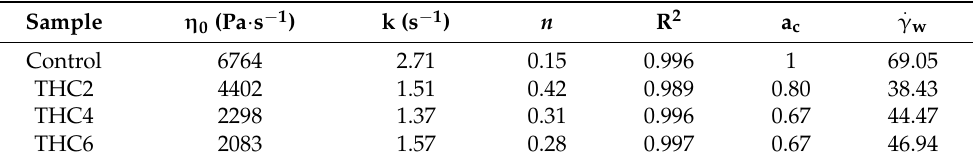
Table 1. Parameters of Williamson model, master curve shift factors, and shear rate values for collagen doughs.